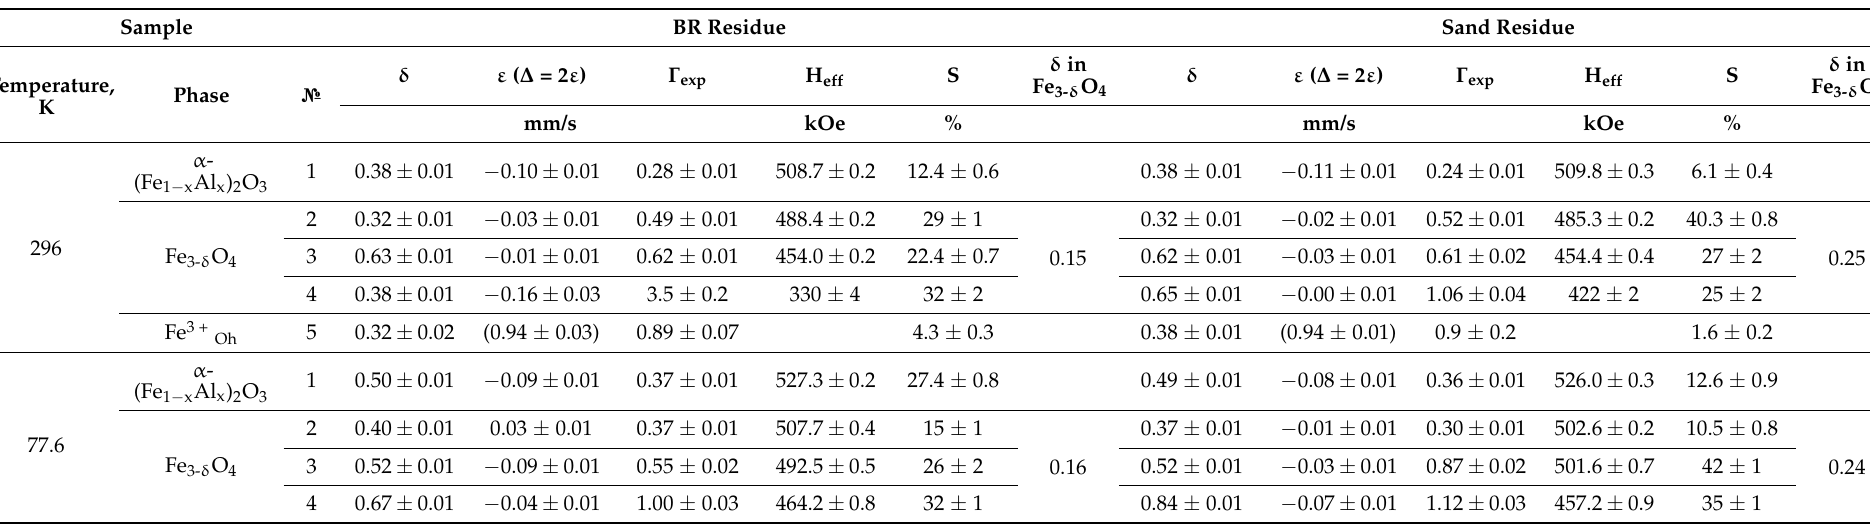
Table 6. The subspectrum parameters describing experimental Mössbauer spectra obtained at varying temperatures for BR residue and sand residue